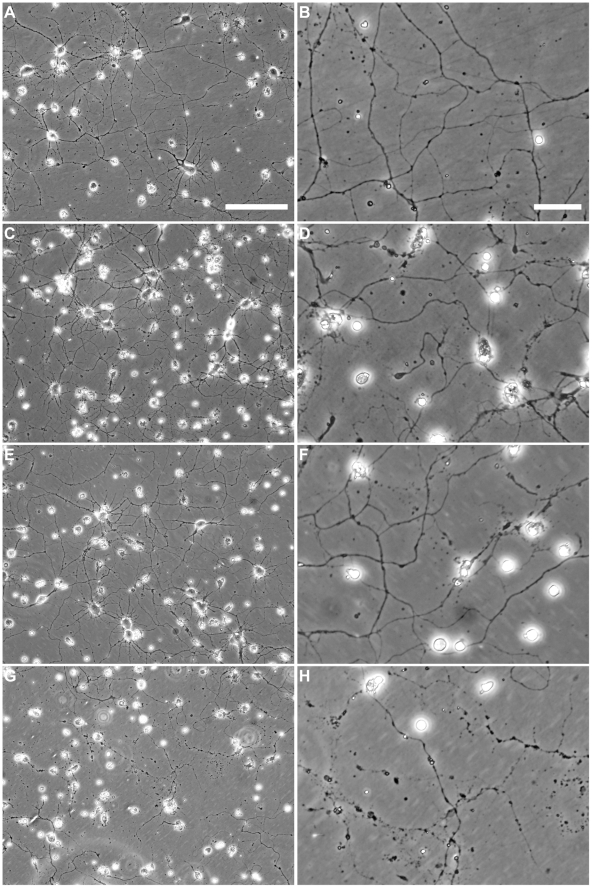
SCILs directly injure stressed neurites in vitro in the absence of viral infection.The neurites of cortical neurons non-lethally stressed by withdrawal of trophic factor support are targets of SCILs-mediated injury despite the complete absence of viral infection. (A, B) Trophic withdrawal alone is insufficient to injure cortical neuron neurites. (C, D) Addition of SCILs collected from 90 dpi B10.Q mice to non-stressed cortical neuron cultures for 120 min did not induce neurite injury. (E, F) Addition of SCILs to stressed cortical neurons for 15 min also did not result in any discernable neurite injury. (G, H) However, by 120 min of SCILs co-incubation with stressed cortical neurons, widespread neurite beading and disintegration was observed. Scale bar in (A) is 100 µm and refers to (A, C, E, G). Scale bar in (B) is 25 µm and refers to (B, D, F, H).